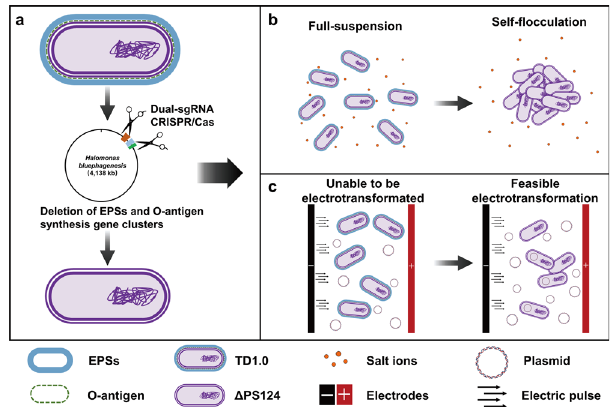
Fig. 9 Illustration of the deletion of EPSs and O-antigen made H . bluephagenesis self- fl occulating and electrotransformation feasible. a EPSs and O-antigen synthesis gene clusters of H . bluephagenesis TD1.0 were deleted with dual-sgRNA CRISPR/Cas strategy, and resulted in H . bluephagenesis Δ PS124. b H . bluephagenesis Δ PS124 can self- fl occulate in the range of 0.4 – 1.0 M NaCl concentration, while H . bluephagenesis Δ PS124 cannot. c H . bluephagenesis Δ PS124 can be transformed by electroporation, whereas H . bluephagenesis Δ PS124